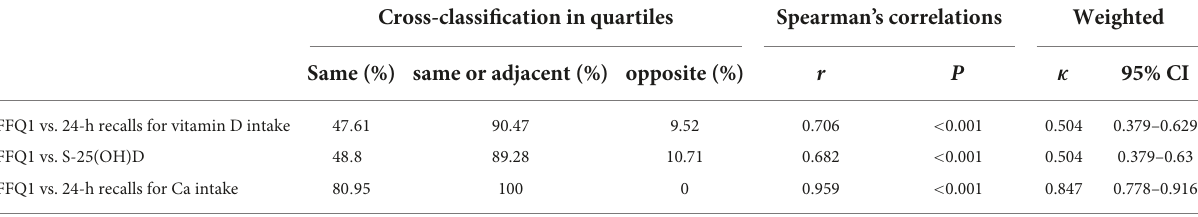
TABLE 3 Cross-classification into quartiles, spearman’s correlations and weighted κ for vitamin D and calcium intake in the validation study ( n = 84). Cross-classification in quartiles Spearman’s correlations Weighted Same (%) same or adjacent (%) opposite